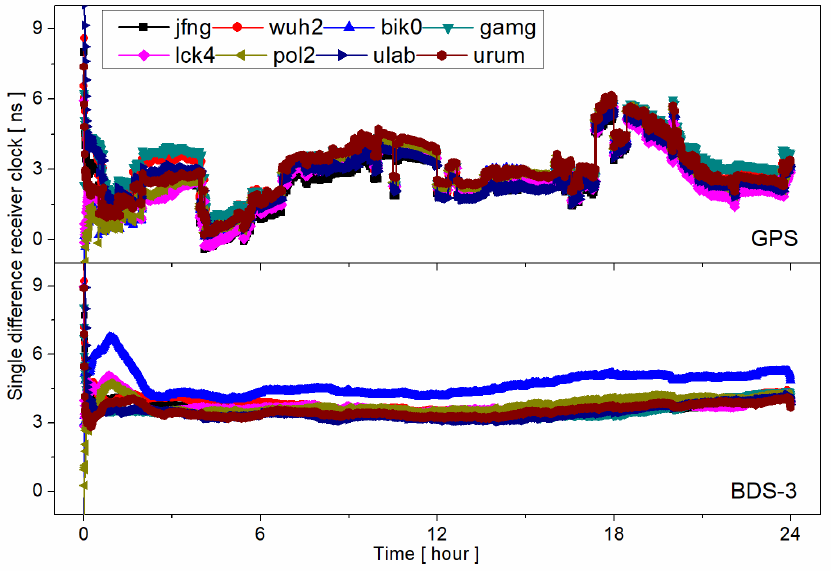
Figure 10. Single-differenced receiver clock series in MJDN 59511; the top and bottom panels are GPS and BDS-3 receiver clocks, respectively.